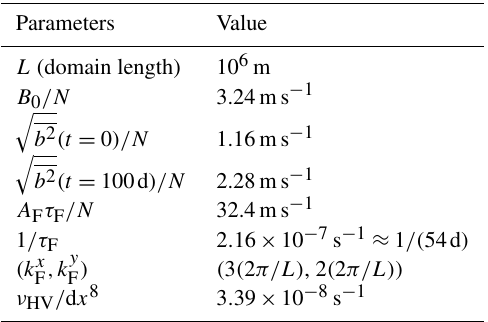
Table 1. Parameters of the